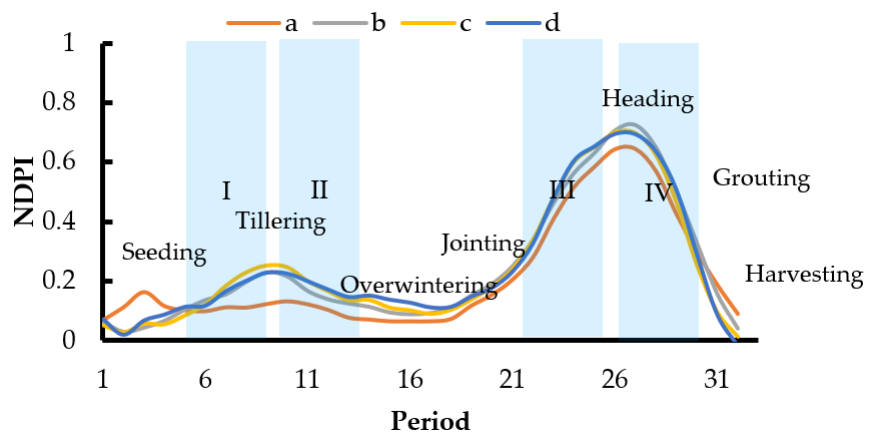
Figure 6. Winter wheat reference curves on different scales and phenological periods of winter wheat. a: Total quadrats; b: Quadrat 1; c: Quadrat 2; d: Study area.